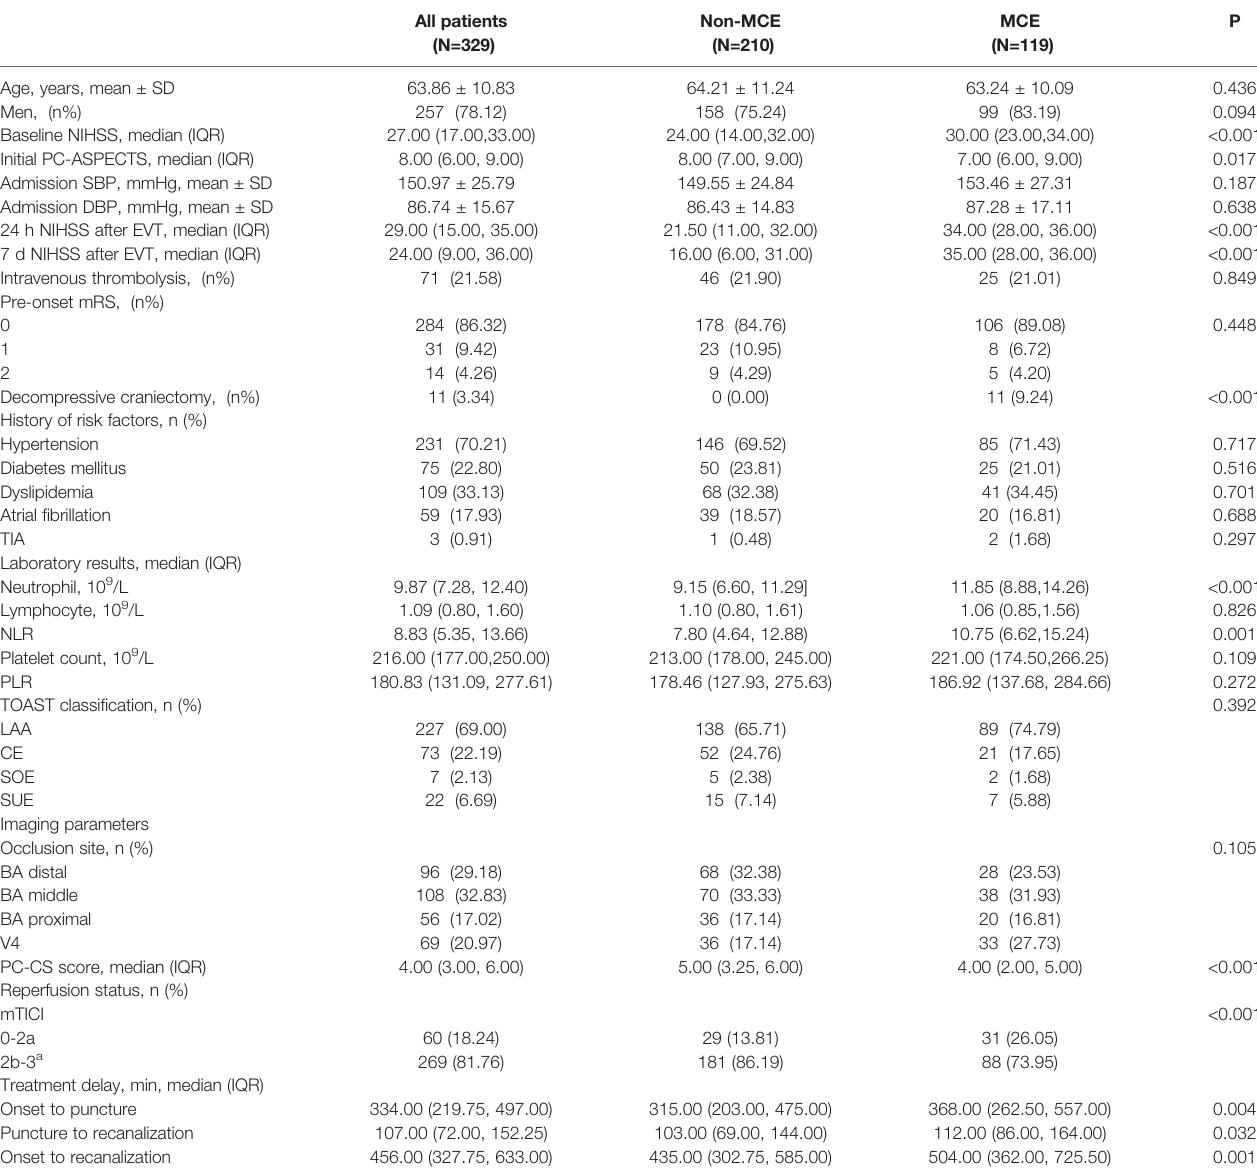
TABLE 1 | Clinical features for enrolled patients strati fi ed by different MCE